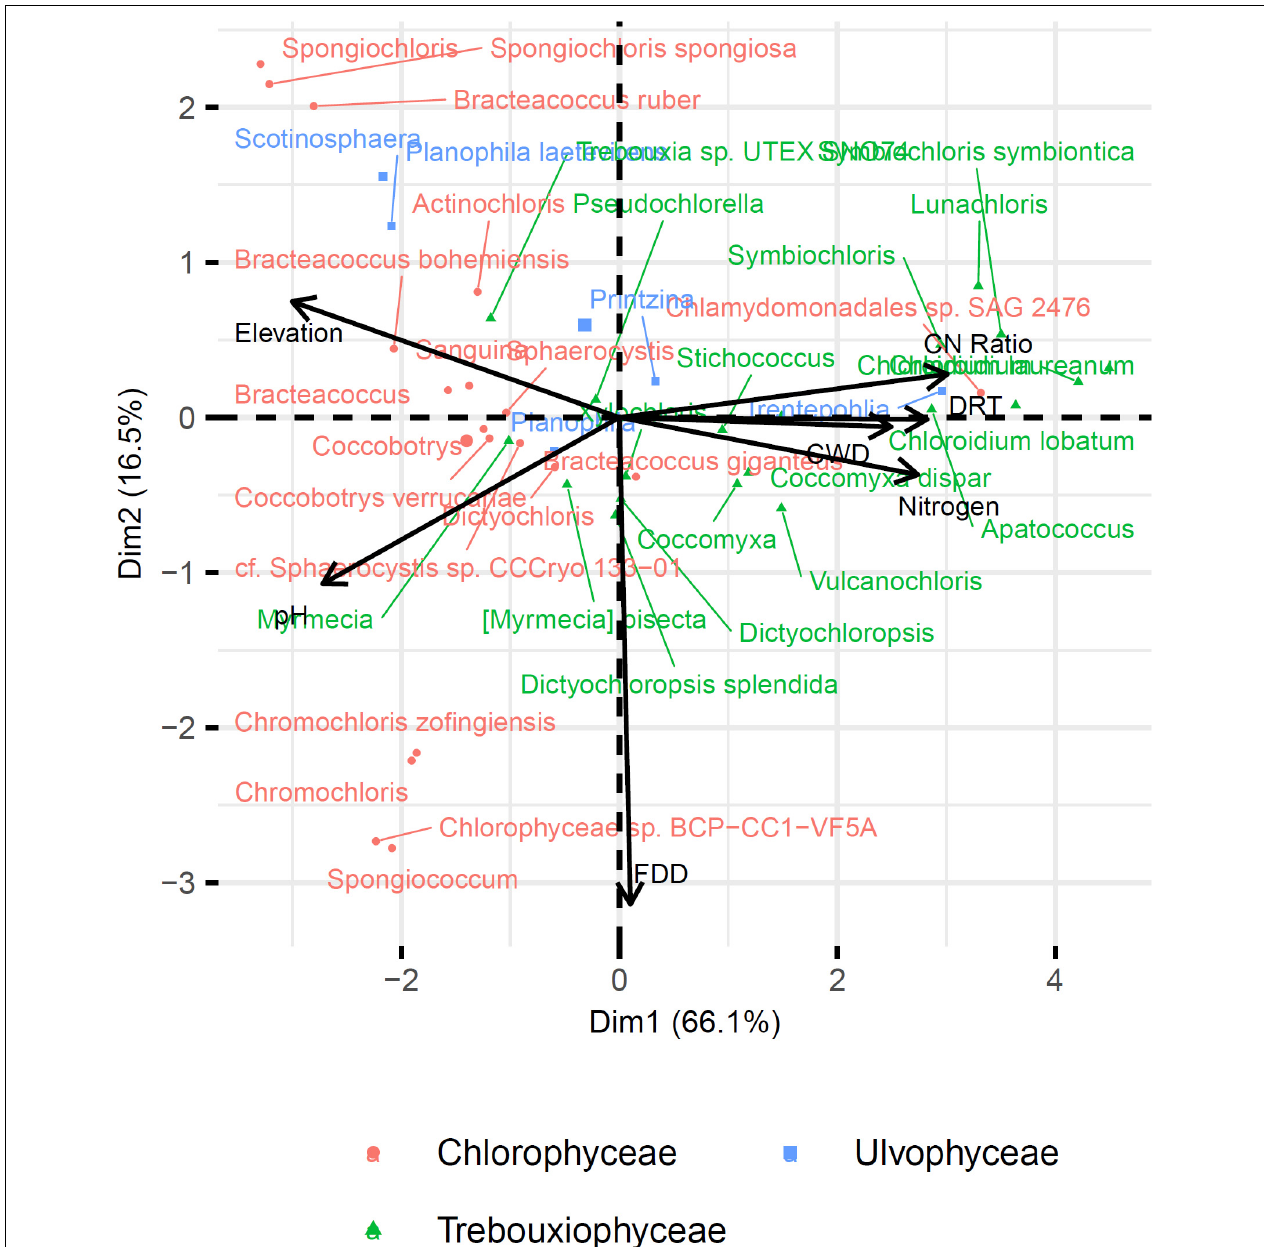
FIGURE 10 | Principal component analysis of the 43 taxa with specialized niche. Taxa are positioned according to the Outlying Mean Index (OMI) of their